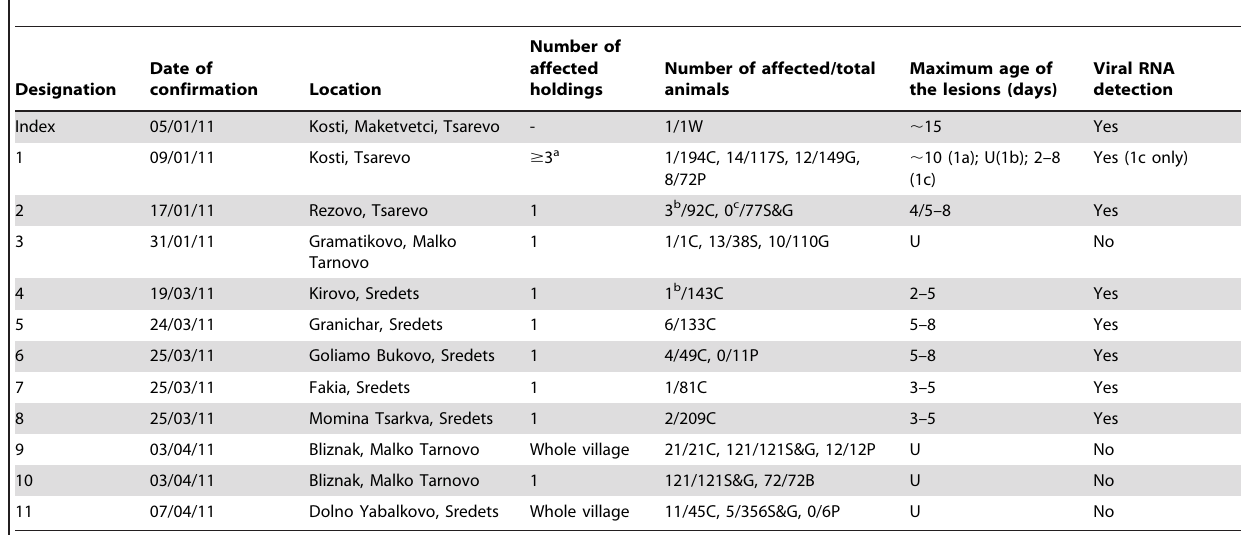
Table 1. Summary of the FMDV outbreaks which occurred in Burgas, Bulgaria,